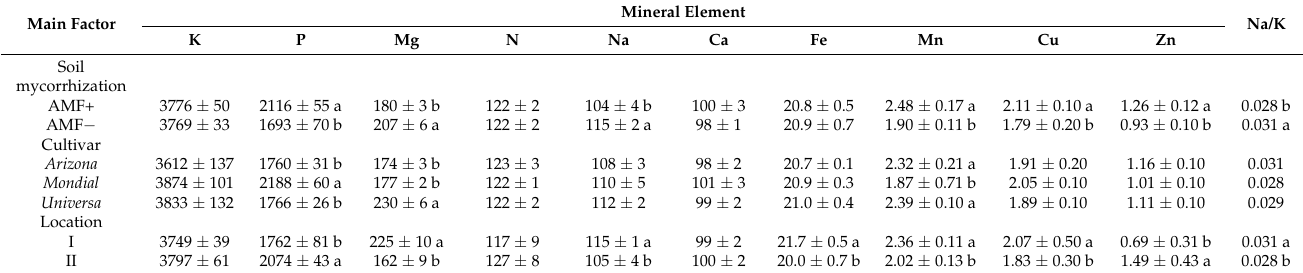
Table 5. Mineral elements (mg kg − 1 of DM) and Na/K ratio as affected by main factors under study. Different letters within the same parameter and main factor show significant differences among means (LSD test, p ≤